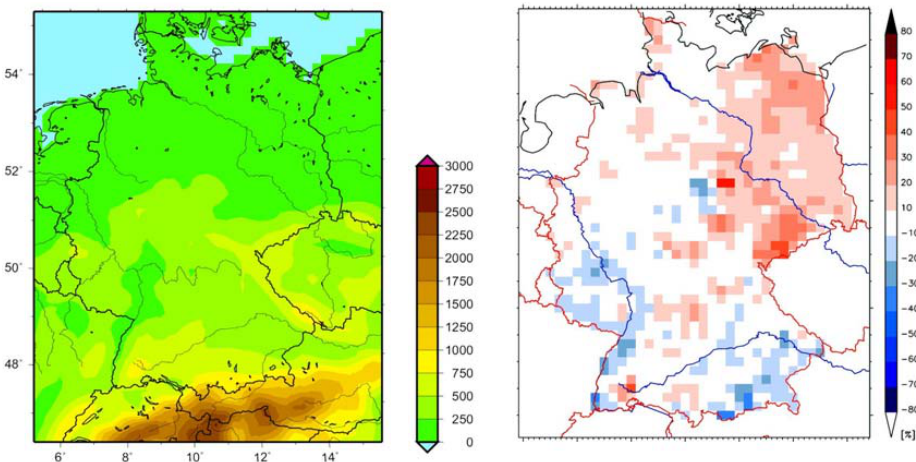
Fig. 1. Terrain elevation (left), and bias of mean annual total precipitation for the RCM (MM5) with respect to the DWD reference data set [%] (Kotlarski et al., 2005)